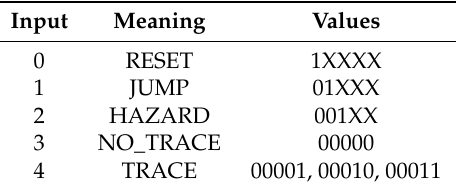
Figure 14. RV32XTrace Trace Control Unit Mealy machine. Table 1. RV32XTrace Trace Control Unit Mealy